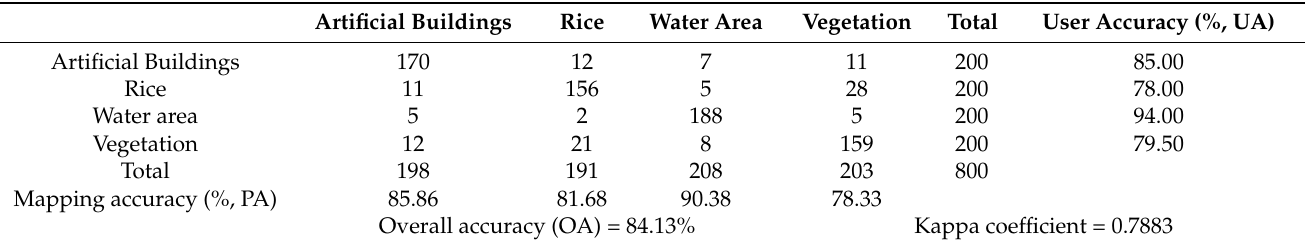
Table 8. Time-series SAR classification accuracy.